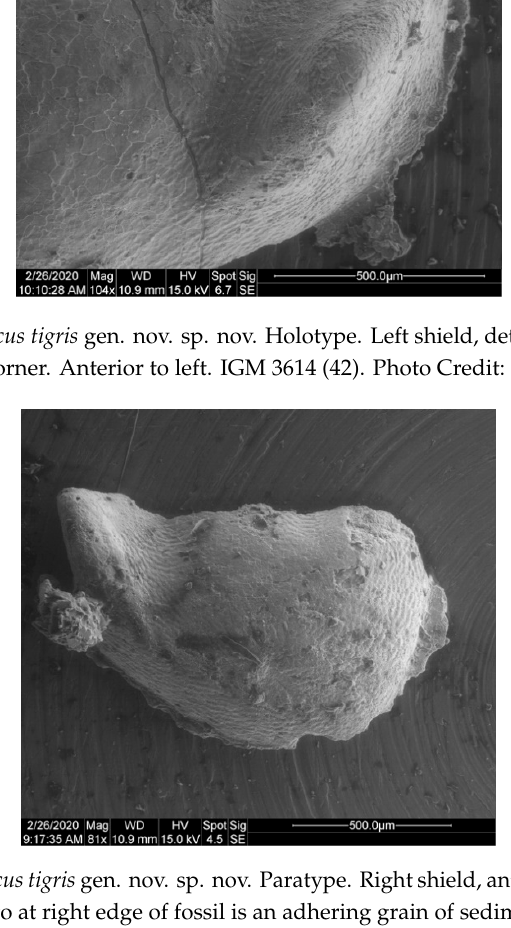
Figure 33. Cambroarchilocus tigris gen. nov. sp. nov. Paratype. Right shield, anterior to right. Hinge area broken. Irregular lump to at right edge of fossil is an adhering grain of sediment. Arcuate scars along ventral margin attributed here to Arcuoichnus pierci nov. ichnogen. nov. ichnosp. IGM 3614 (43). Photo Credit: Mark McMenamin.